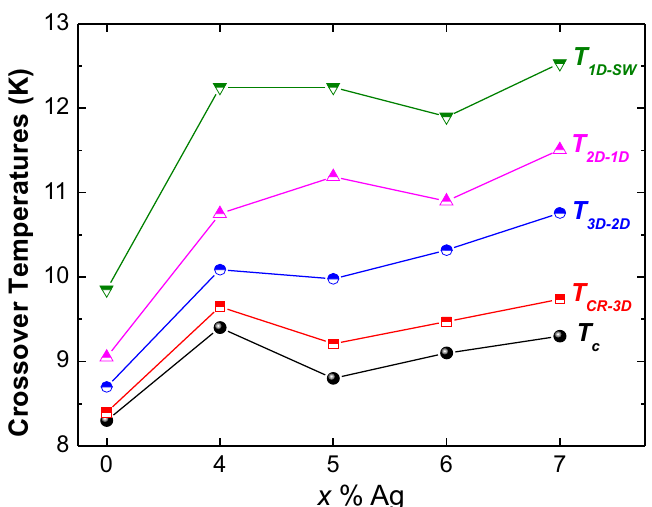
Figure 8. Plot of the various crossover temperatures determined from the FIC analysis as a function of the Ag content, together with the respective T c